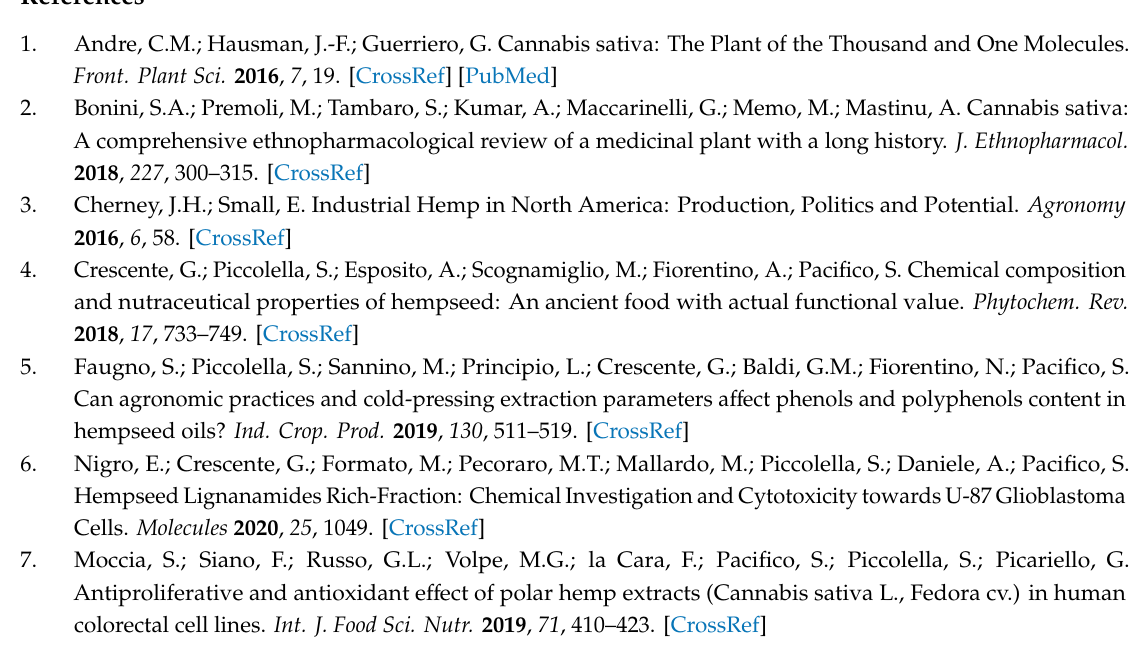
Figure S1: XIC, HR-MS and MS / MS of ca ff eine. In the table, its amount is reported as wt % of dried moka co ff ee drinks (Cof-A = co ff ee enriched with C. sativa cv . Antal shredded inflorescences; Cof-K = co ff ee enriched with C. sativa cv . Kompolti shredded inflorescences; Cof-T = co ff ee enriched with C. sativa cv . Tiborszallasi shredded inflorescences), Figure S2: Chemical structures of the main chlorogenic acids (CQA = ca ff eoylquinic acid; CQAL = ca ff eoylquinic acid lactone; FQA = feruloylquinic acid; FQAL = feruloylquinic acid lactone), Figure S3: XIC (selecting the ion at m / z 353.09 ± 0.025) and HR-MS / MS of monoca ff eoylquinic acids (CQAs) (Cof-A = co ff ee enriched with C. sativa cv . Antal shredded inflorescences; Cof-K = co ff ee enriched with C. sativa cv . Kompolti shredded inflorescences; Cof-T = co ff ee enriched with C. sativa cv . Tiborszallasi shredded inflorescences), Figure S4: XIC (selecting the ion at m / z 515.10 ± 0.025) and HR-MS / MS of di-ca ff eoylquinic acids (di-CQAs) (Cof-A = co ff ee enriched with C. sativa cv . Antal shredded inflorescences; Cof-K = co ff ee enriched with C. sativa cv . Kompolti shredded inflorescences; Cof-T = co ff ee enriched with C. sativa cv . Tiborszallasi shredded inflorescences), Figure S5: XIC (selecting the ion at m / z 335.08 ± 0.025) and HR-MS / MS of dehydrated derivatives of ca ff eoylquinic acids (CSAs / CQALs) (Cof-A = co ff ee enriched with C. sativa cv . Antal shredded inflorescences; Cof-K = co ff ee enriched with C. sativa cv . Kompolti shredded inflorescences; Cof-T = co ff ee enriched with C. sativa cv . Tiborszallasi shredded inflorescences), Figure S6: XIC (selecting the ion at m / z 367.08 ± 0.025) and HR-MS / MS of feruloylquinic acids (FQAs) (Cof-A = co ff ee enriched with C. sativa cv. Antal shredded inflorescences; Cof-K = co ff ee enriched with C. sativa cv . Kompolti shredded inflorescences; Cof-T = co ff ee enriched with C. sativa cv . Tiborszallasi shredded